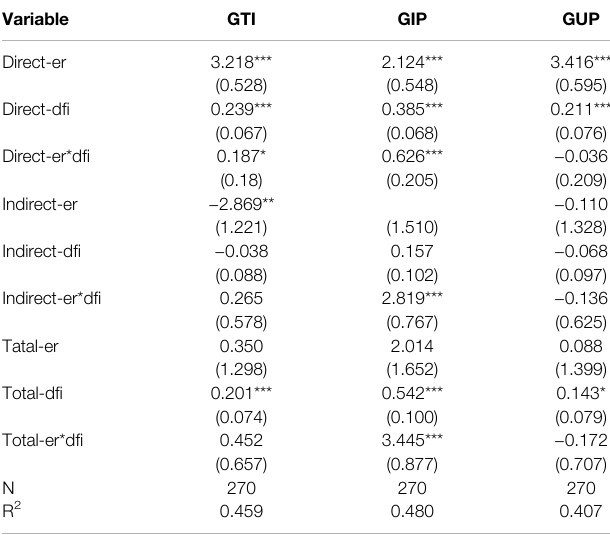
TABLE 7 | Spatial effect decomposition considering interaction terms. Variable